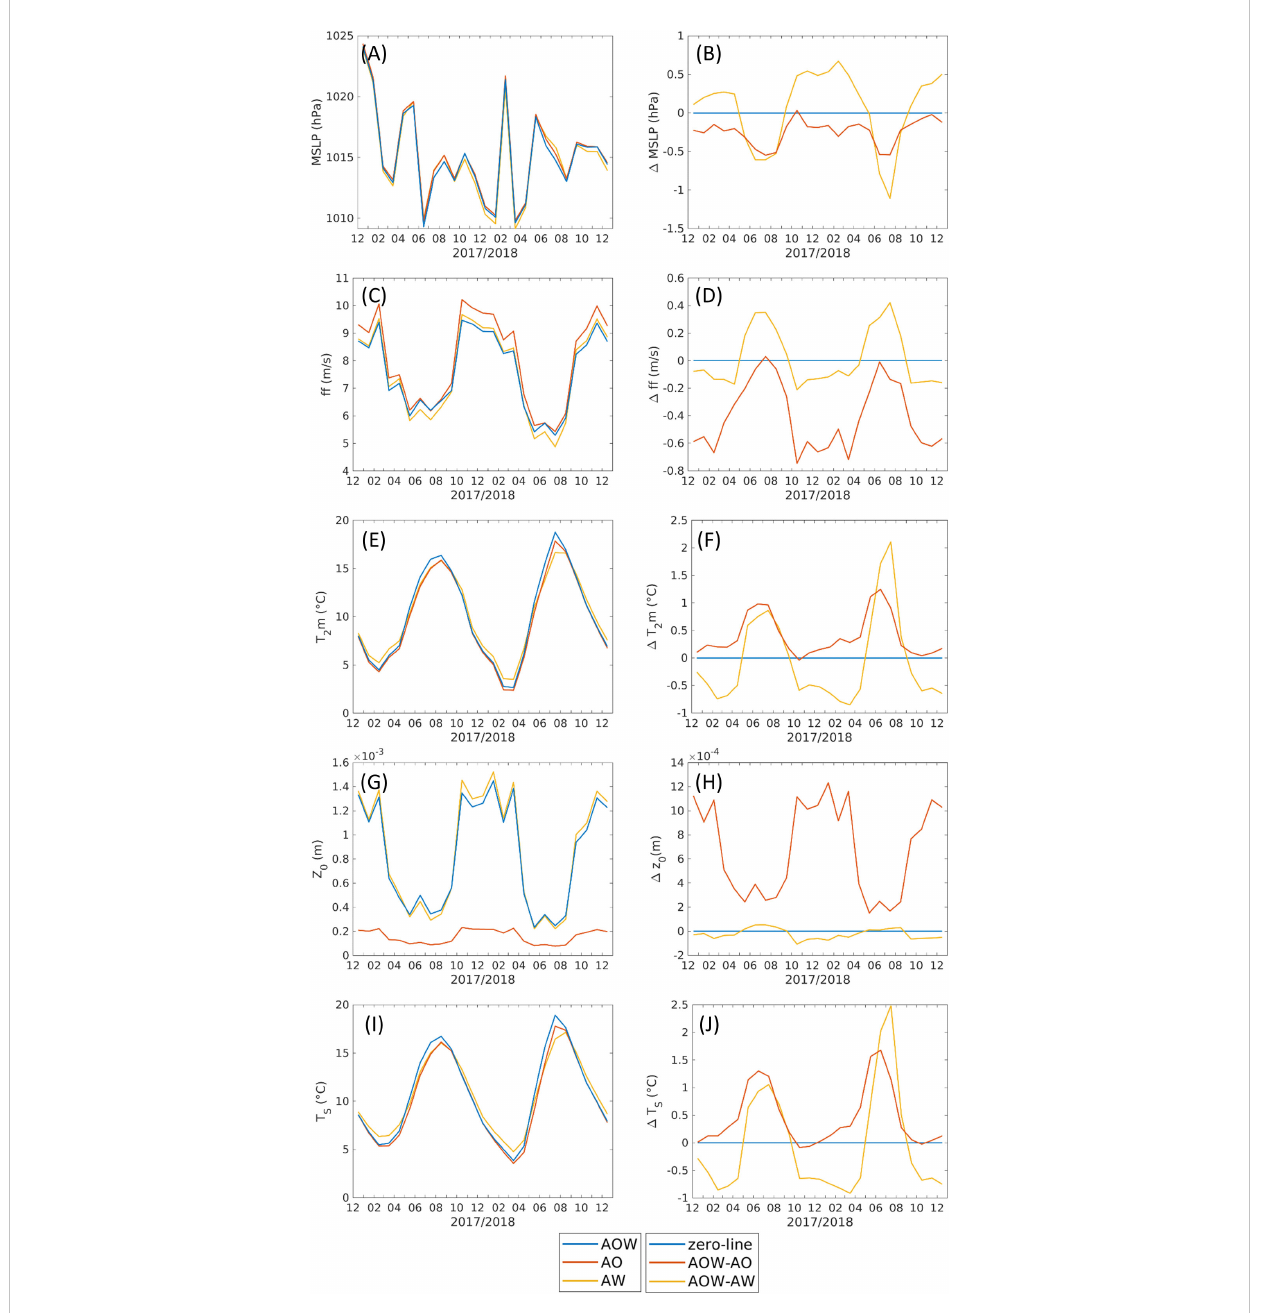
FIGURE 4 Time series of monthly mean of mean sea level pressure (A) , 10-m wind speed (C) , 2-m air temperature (E) , roughness length (G) , and surface temperature (I) within the North Sea area for all three simulations as well as the differences with respect to AOW, which is represented by the zero line (B, D, F, H, J) . The time series represent equally weighted